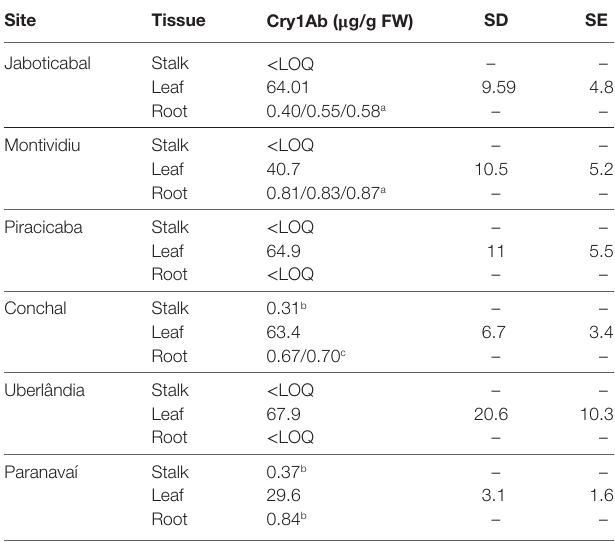
TaBle 4 | Concentration of Cry1Ab protein in tissues of CTC175-A event evaluated via ELISA ( n = 4). site Tissue cry1ab ( μ g/g FW)